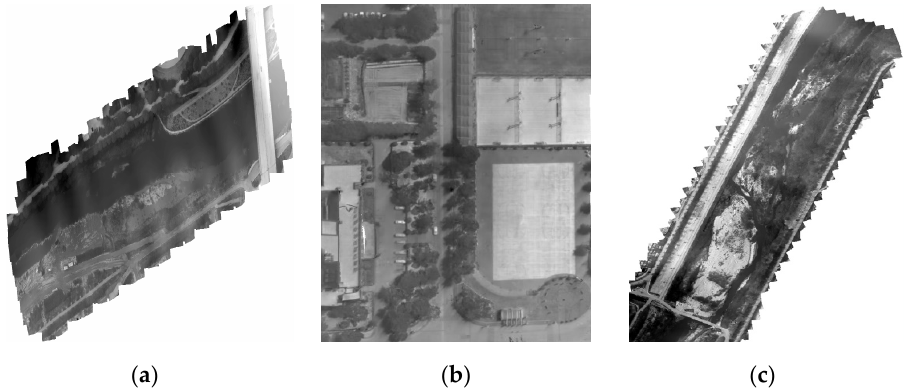
Figure 5. Orthophotos converted from DN value orthophotos to LST value (Among the 27 orthophotos, only the one with a camera angle of 80° for 3 sites is shown as an example.): ( a ) 28 July 2021; ( b ) 29 July 2021; ( c ) 30 July 2021.